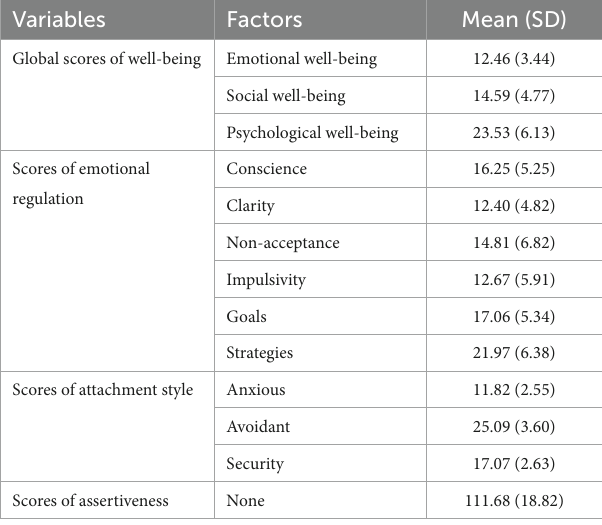
TABLE 3 Mean scores, standard deviations of participant scores.